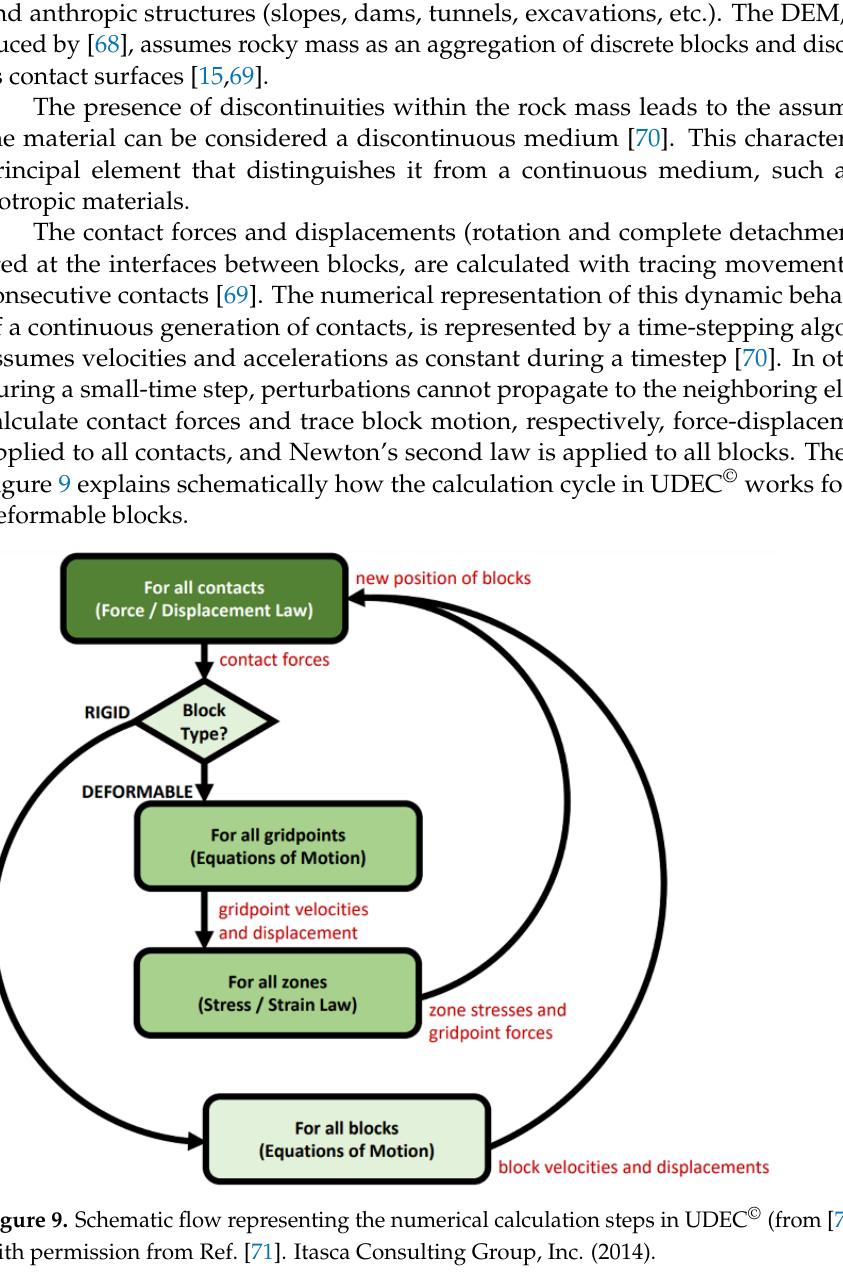
Figure 10. S1-C1 ( A ) and S2-C2 ( B ) cross-sections of the Sottovettolina underground marble quarry. Lithologies and discontinuities are indicated by colors, as follows: red = cherty meta-limestone; yellow = radiolarian chert; light blue = marble; black = lithologi- cal boundary; blue = marble discontinuity. The model blocks were considered deformable, and the assigned constitutive models were, respectively, the Mohr–Coulomb plasticity model [66] for lithologies, and the Cou- lomb slip model for discontinuities [67], in analogy to what had been established in the RS3 © modeling. The same approach, described in Paragraph 3.2.1, was used for the dis- continuities affecting the rock mass. Only the main discontinuities on the quarry walls were modeled in such a way to avoid that real spacing, derived from the engineering– geological surveys, would excessively fragment the model. The real spacing of joints would cause the material to behave as a continuous medium and, therefore, was not op- timal for DEM analysis. Model boundaries were fixed by resetting the X and Y velocities along the bottom and the left model limit. Gravity was fixed at 9.81 m/s 2 . To trace the stress evolutions during the calculation, the function “history” was set in correspondence of the CSIRO HI cell measurements aiming to monitor the xx, xy, and yy stress tensor values (Figure 10). Before assessing the stability of the quarry fronts, the models were firstly solved to check their initial equilibrium with gravity as the only applied force.